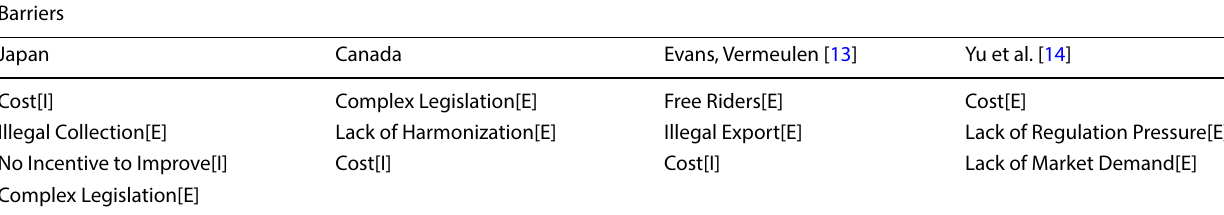
Table 9 Classification of importance of top three barriers between cases and literature